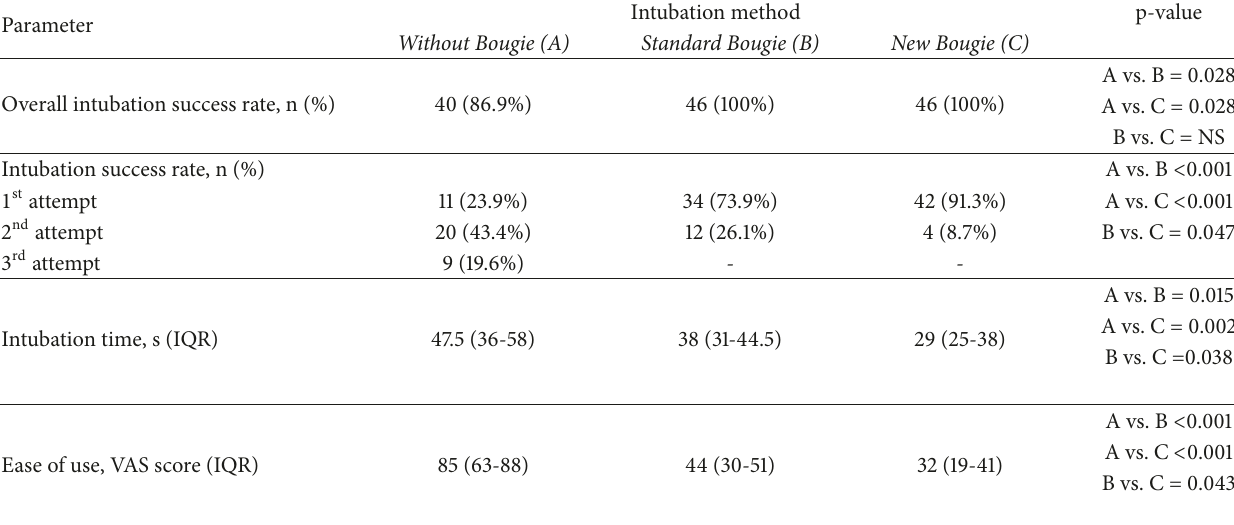
Table 1: Intubation success rates, time, and ease in the analysed groups.